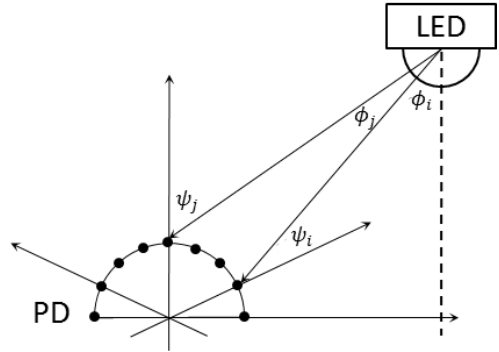
Figure 10. Circular PD array for estimating